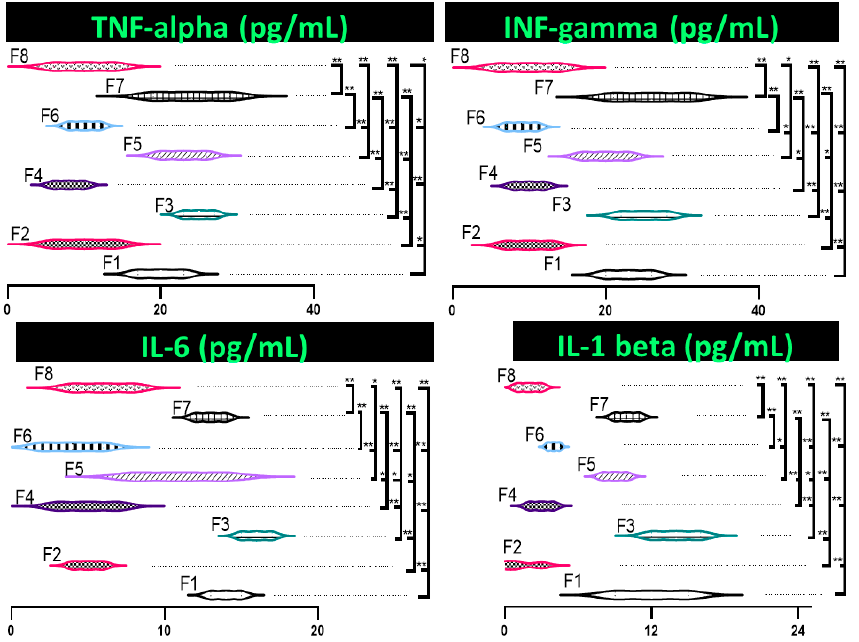
Figure 3. Inflammatory markers of encapsulated cells. Cytokines include tumour necrosis factor ‐ alpha (TNF ‐ alpha), intrerfeuron ‐ gamma (IFN ‐ gamma), interleukin ‐ 6 (IL ‐ 6), and interleukin ‐ 1 beta alpha (TNF-alpha), intrerfeuron-gamma (IFN-gamma), interleukin-6 (IL-6), and interleukin-1 beta (IL ‐ 1 beta). Data are mean ± SEM, n = 3. * p < 0.05, ** p < 0.01. (IL-1 beta). Data are mean ± SEM, n = 3. * p < 0.05, ** p <